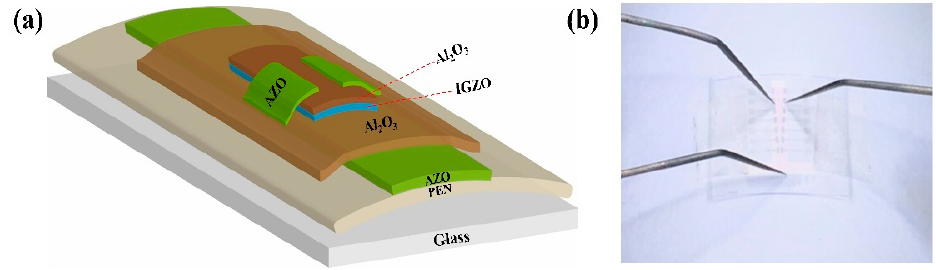
Figure 1. ( a ) Schematic illustration, ( b ) the digital photo. The interface structure, cross-sectional morphology, and composition distribution of TFTs were measured by transmission electron microscopy (TEM, JEOL JEM-2100F). The surface band structure was measured by the X-ray photoelectron emission spectroscopy using Thermo VG ESCALAB 250 photoelectron spectrometer. The electrical characteriza- tions of TFTs were measured by the semiconductor parameter analyzer (Agilent,